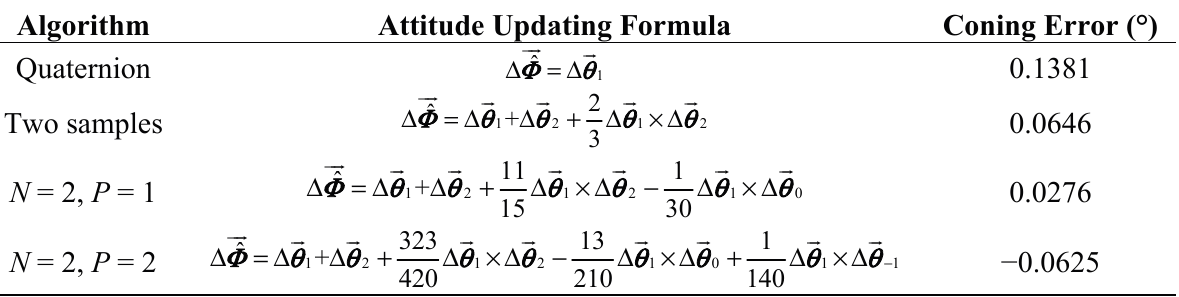
Table 1. Comparison of the accuracy of the four attitude updating algorithms.